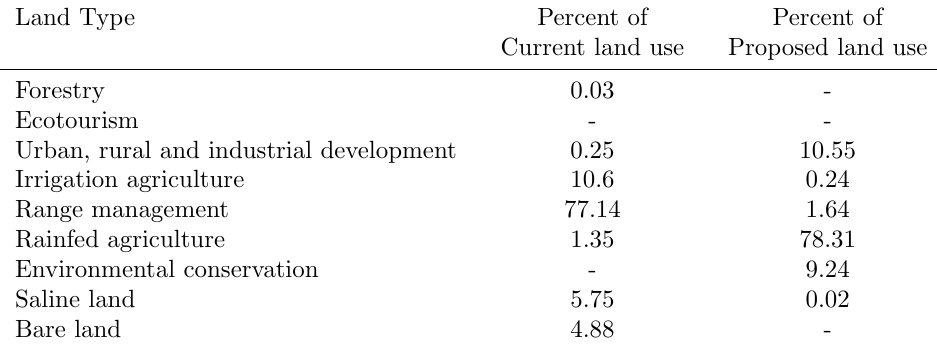
Table 5: Comparison of land percent in Current land use and proposed land use maps Land Type Percent of Percent of Current land use Proposed land use Forestry 0.03 Ecotourism Urban, rural and industrial